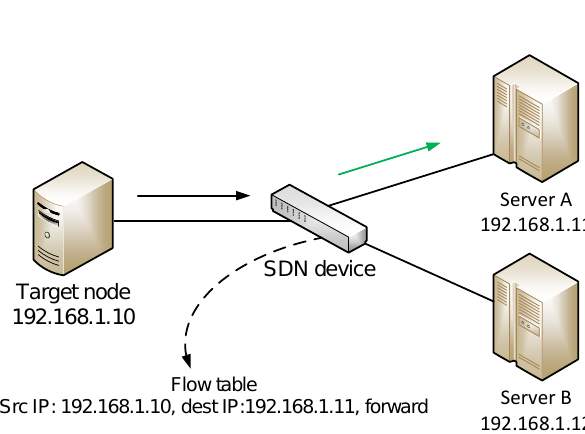
Figure 2. Network Configuration